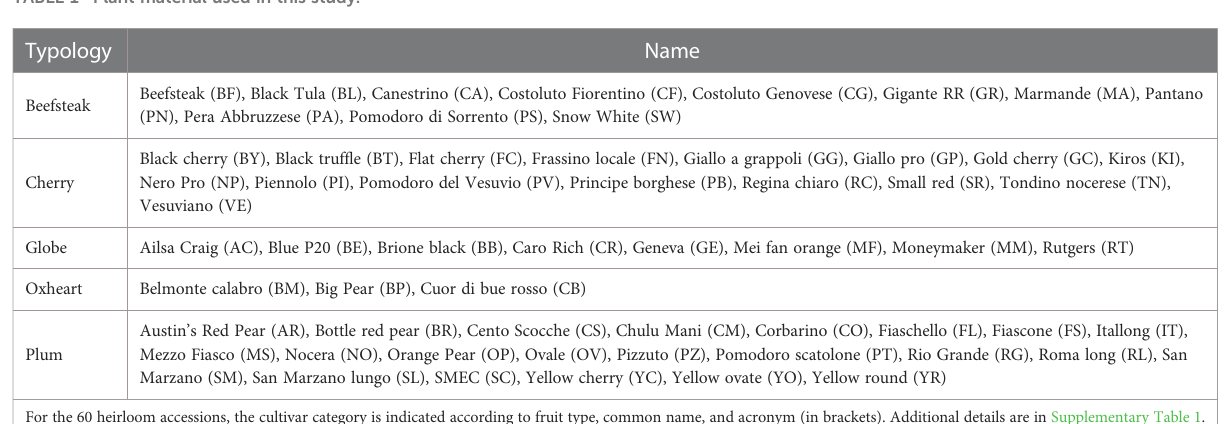
TABLE 1 Plant material used in this